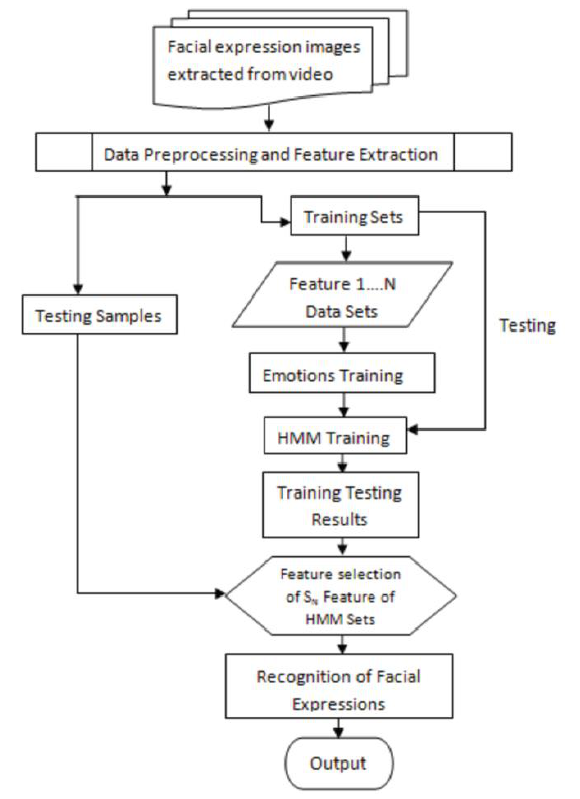
Figure 1: Stages of Emotion Detection. (Mishra, P., & Ratnaparkhi, S.,